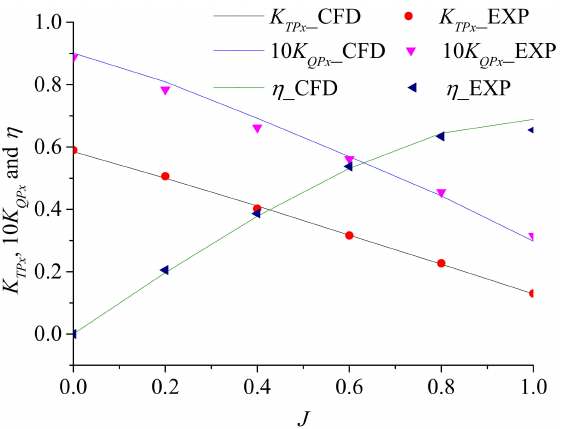
Figure 10. Hydrodynamic performance comparison curve between the experiment and numerical simulation of the podded propeller.